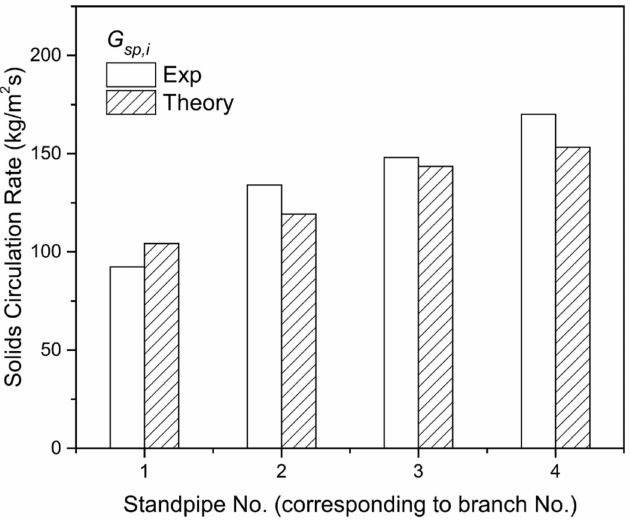
Figure 11. Solids circulation rate of four standpipes of C-type mode (corresponding to four connection